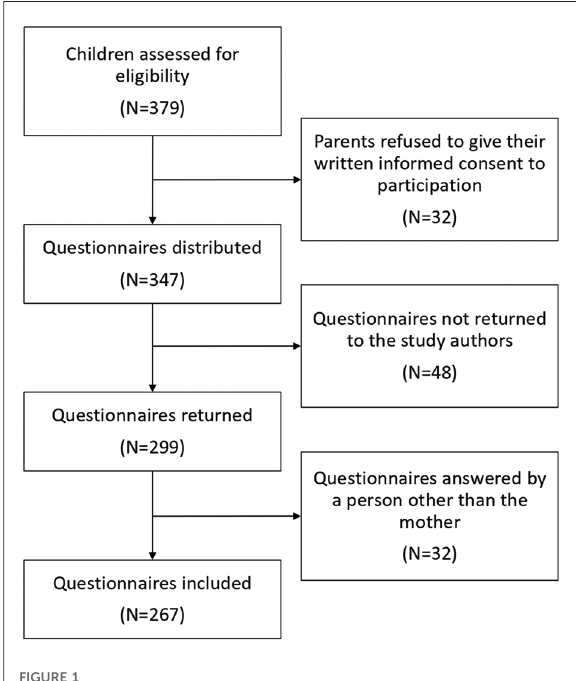
FIGURE 1 Flowchart diagram representing children lost to follow-up and included in the fi nal analysis and the reasons for a